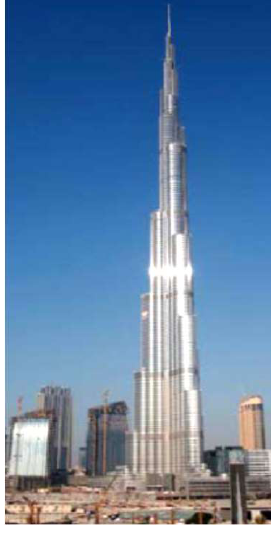
Figure 12. Photo of the completed tower. Source: [6].